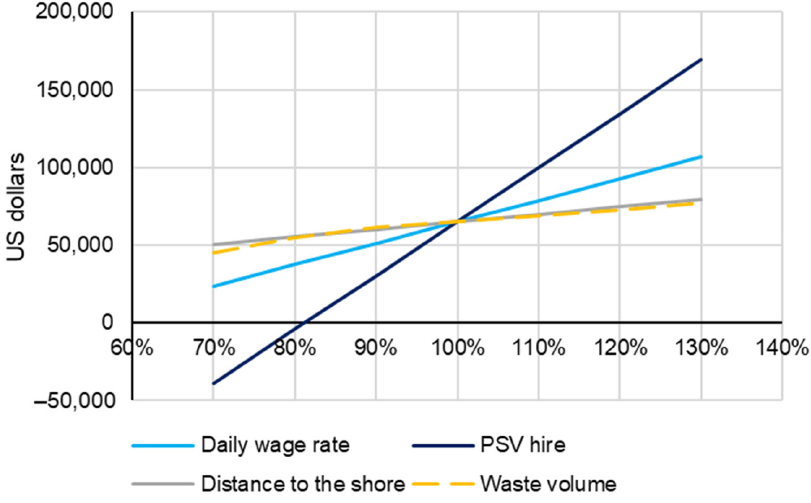
Figure 8. Sensitivity analysis of Skip and Ship method.